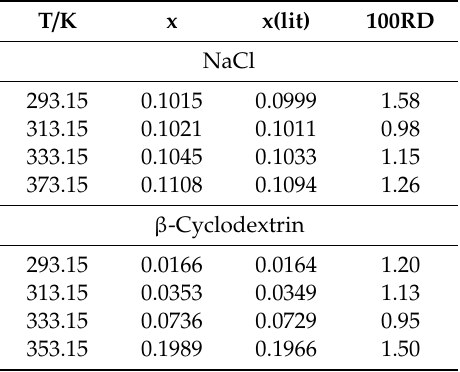
Table 1. Solubility of NaCl in